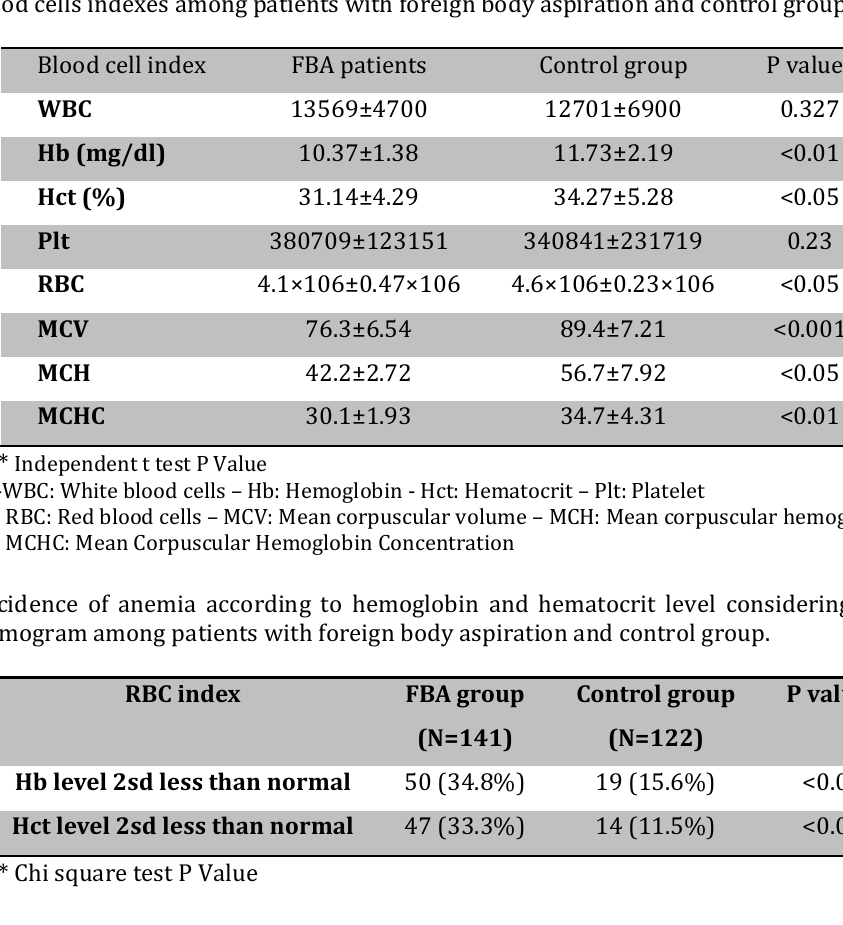
Table 2. Blood cells indexes among patients with foreign body aspiration and control group.